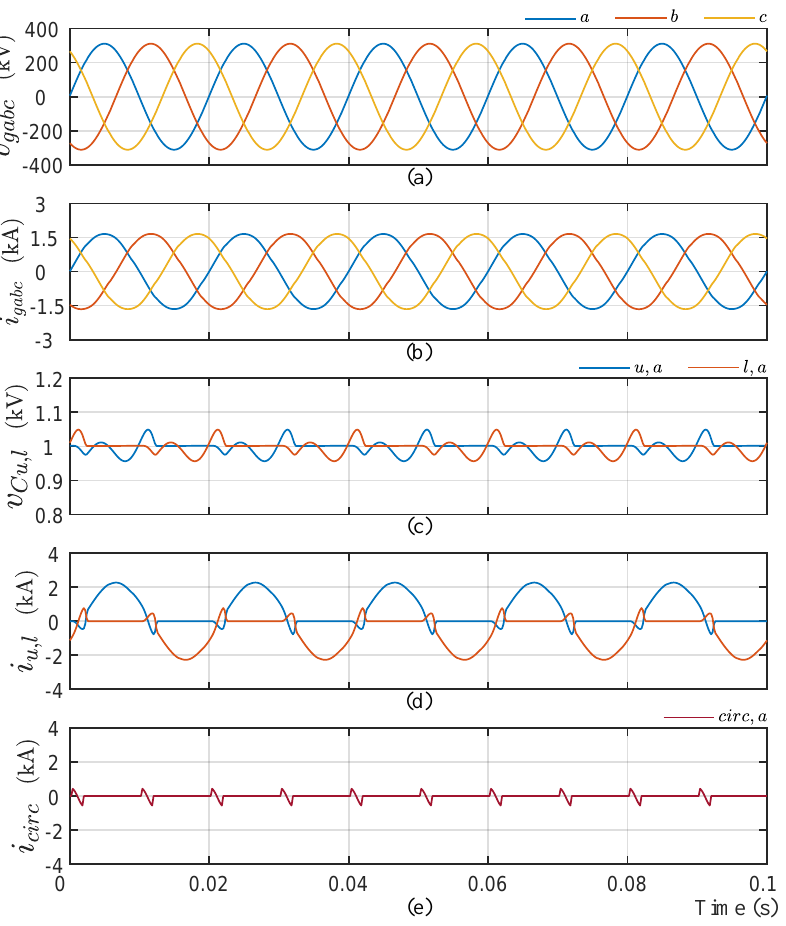
Figure 7. Steady-state operation of the AAC: ( a ) ac voltages, ( b ) ac currents, ( c ) average SM capacitor voltages of phase a , ( d ) arm currents of phase a , and ( e ) circulating current of phase a